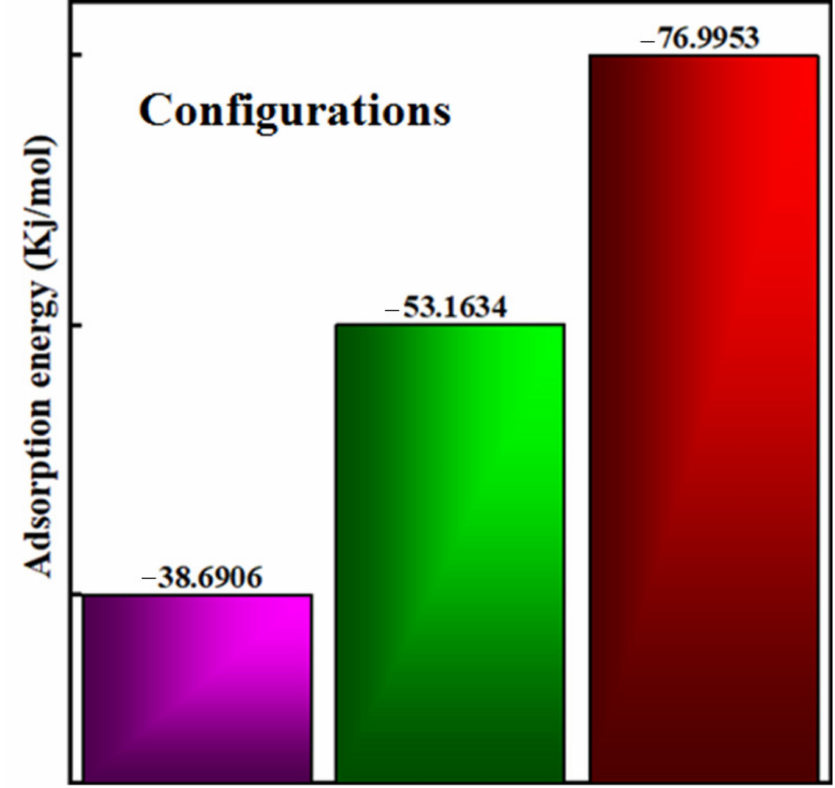
Figure 5. Calculated adsorption energy of the complex of different